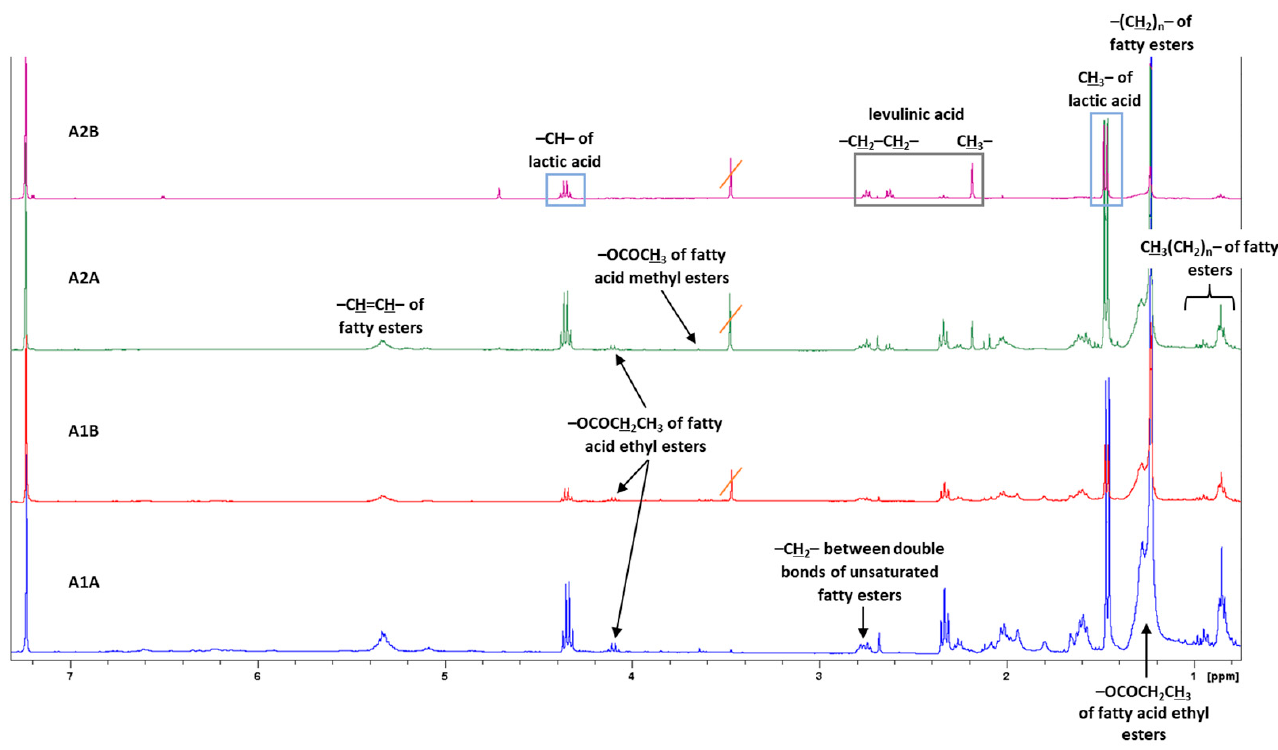
Figure 1. 1 H-NMR spectra (CDCl 3 , 400 MHz) of non-polar extracts from Dioscorea communis . A1A = ether extract; A1B = dichloromethane extract; A2A = ether extract after acid hydrolysis; and A2B = dichloromethane extract after acid hydrolysis.